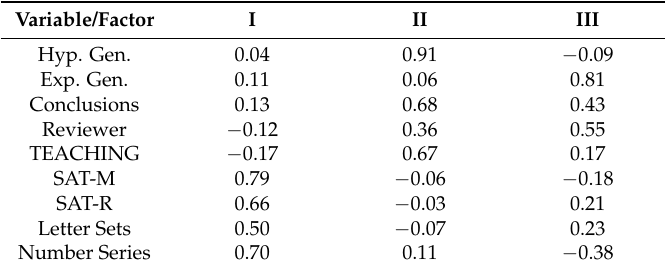
Table 5. Principal-Components Analysis with Varimax-Rotated